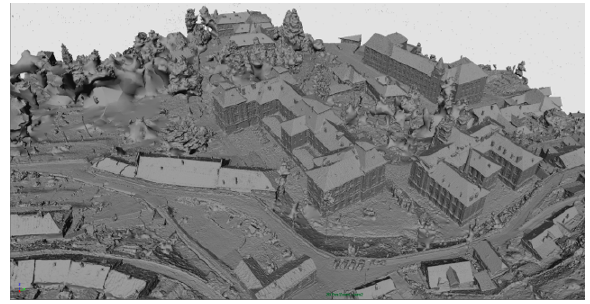
Figure 29. Untextured polygonal model of Banská Štiavnica